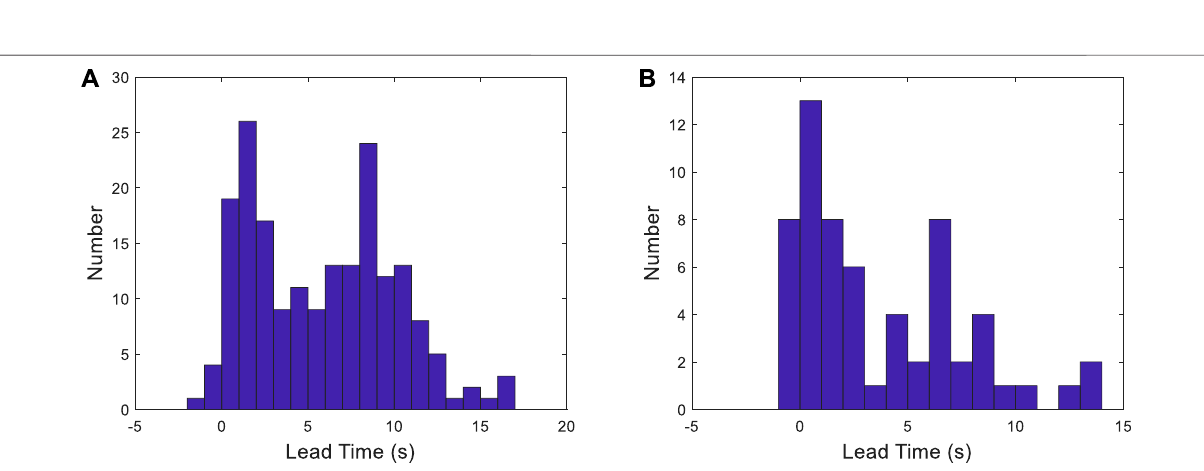
Frontiers in Earth Science |